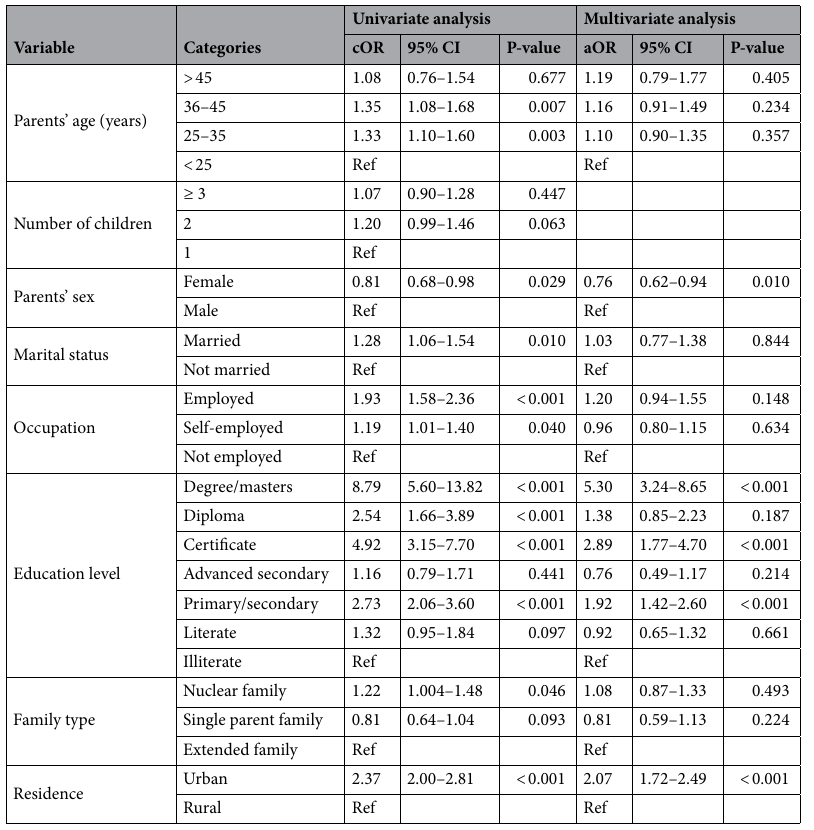
Table 5. Univariate and multivariate analysis of factors associated with parents’ positive attitude on appropriate use of antibiotic in children. cOR crude odds ratio, aOR adjusted odds ratio, 95%CI 95% confidence interval, Ref reference